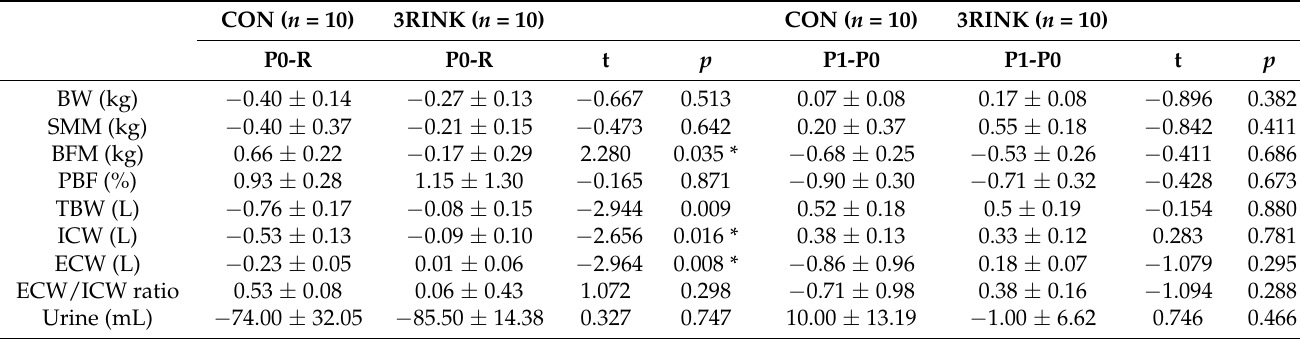
Table 2. Body composition according to the type of fluids and intake